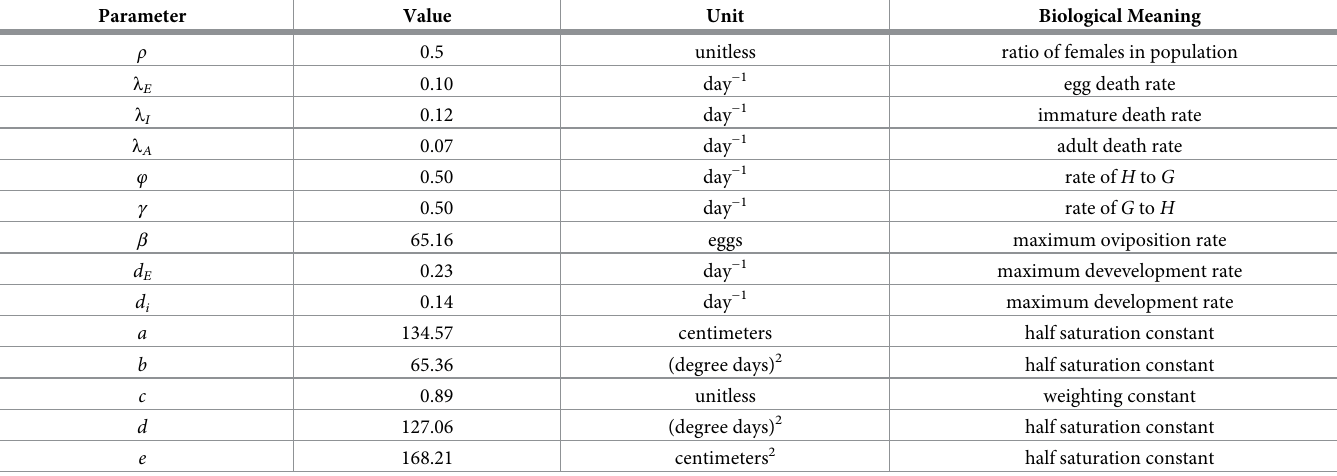
Table 1. Best fit parameters for mosquito population